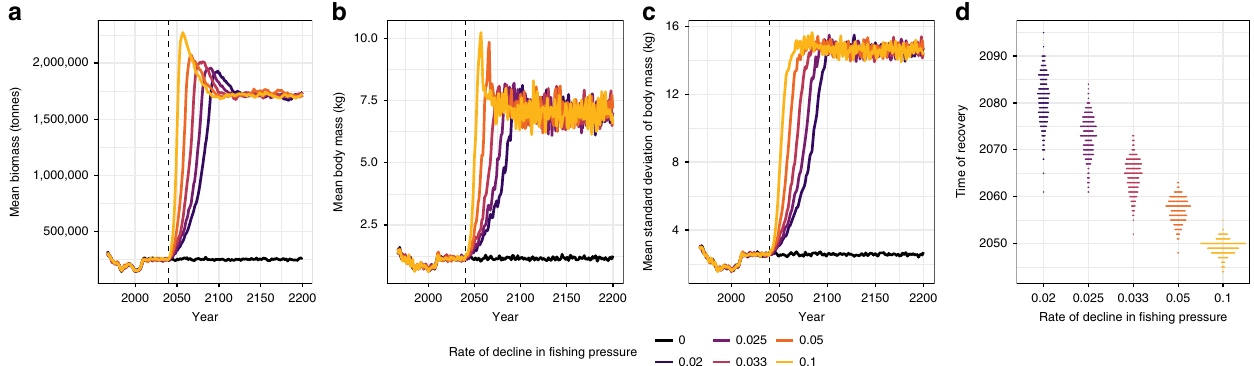
Fig. 1 Projected cod population dynamics and recovery times under various rates of decline in fi shing pressures. The model predicts signi fi cant increases in ( a ) mean biomass, ( b ) mean body size, ( c ) σ size as fi shing pressures decline, with recovery times ( d ) changing approximately linearly with the rate of decline in fi shing pressure. Each line represents the mean of 300 simulations